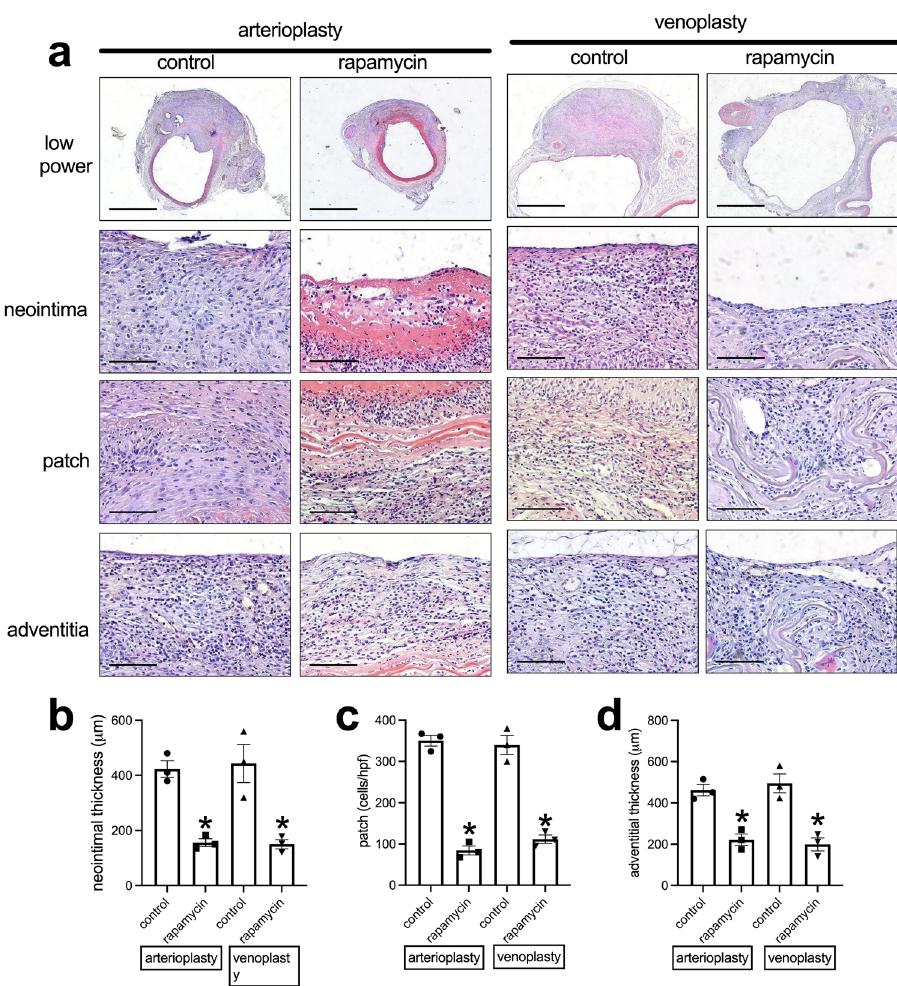
Fig. 3 Swim bladder patches harvested from aorta arterioplasty and IVC venoplasty at day 14. a Photographs of hematoxylin & eosin staining of the swim bladder patches after arterioplasty or venoplasty, day 14. First row, low power photographs, scale bar, 1 mm; second to fourth rows, high-power photographs shows the neointima, cells in fi ltrated into the patch and the newly formed adventitia; scale bar, 100 μ m; n = 3. b Bar graph showing the neointimal thickness in the arterioplasty (* p = 0.013) and venoplasty (* p = 0.0147) models, day 14; t -test; n = 3. c Bar graph showing the cells in fi ltrated into the patch in the arterioplasty (* p = 0.0001) and venoplasty (* p = 0.0008) models, day 14; t -test; n = 3. d Bar graph showing the adventitial thickness in the arterioplasty (* p = 0.0037) and venoplasty (* p = 0.0059) models, day 14; t -test; n = 3. Data are expressed as mean ±